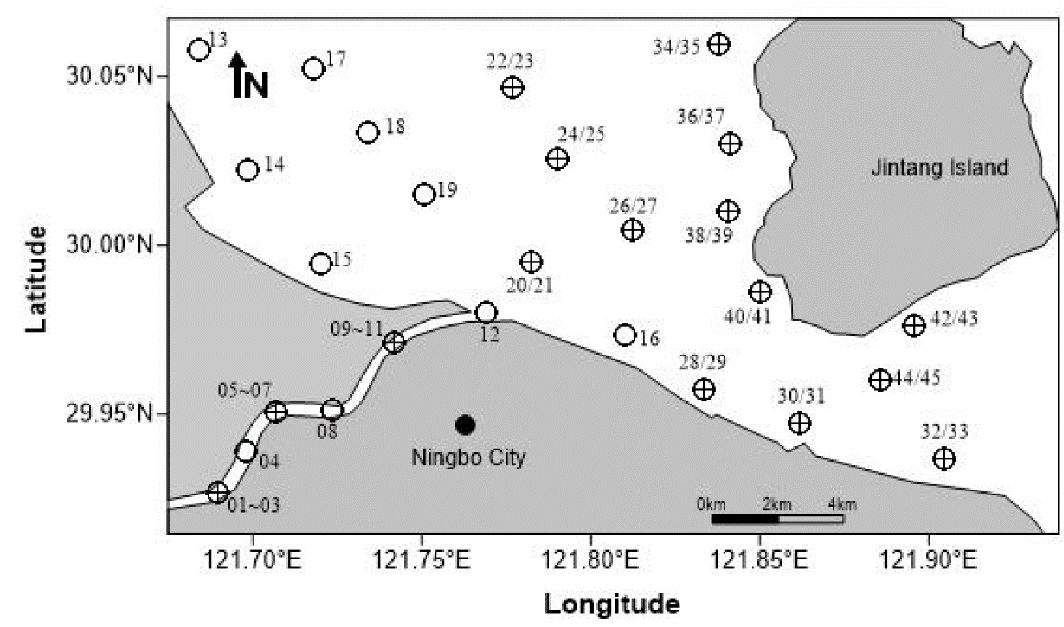
Figure 2. Sampling locations in the lower reach and the estuary of the Yongjiang River. The 26 locations account for 45 points, 12 in the lower reach of the river and 33 in the estuary. Of the 12 points, nine were taken from three cross-sections, sampled evenly along the section three times. The other 33 points (with numbers 13 through 45) were taken in 20 locations in the estuary, with 13 locations sampled in both upper and lower water. Single sampling points were marked with “ ◯ ” in their locations, while the multiple ones were marked with “ ⊕ ”.